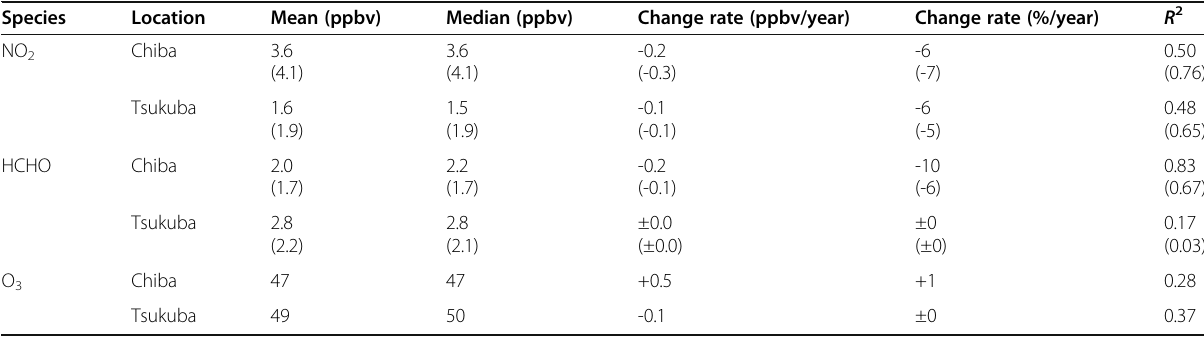
Table. 1. Means, medians, and change rates for NO 2 , HCHO, and O 3 concentrations in the lowest layer (altitude of 0 – 1 km) retrieved from MAX-DOAS observations at Chiba and Tsukuba, Japan, for 2013 – 2019. The change rates and determination coefficient ( R 2 ) were calculated by a linear least-squares fit. Statistics for the 8 months of March to October, when MAX-DOAS O 3 data were available, are given. For NO 2 and HCHO, statistics for 12 months are also given in brackets